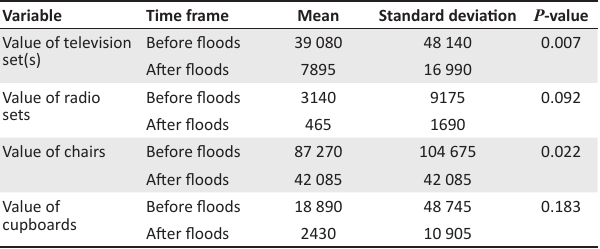
TABLE 3: Changes in value of selected physical assets resulting from the 2012 Babessi floods.